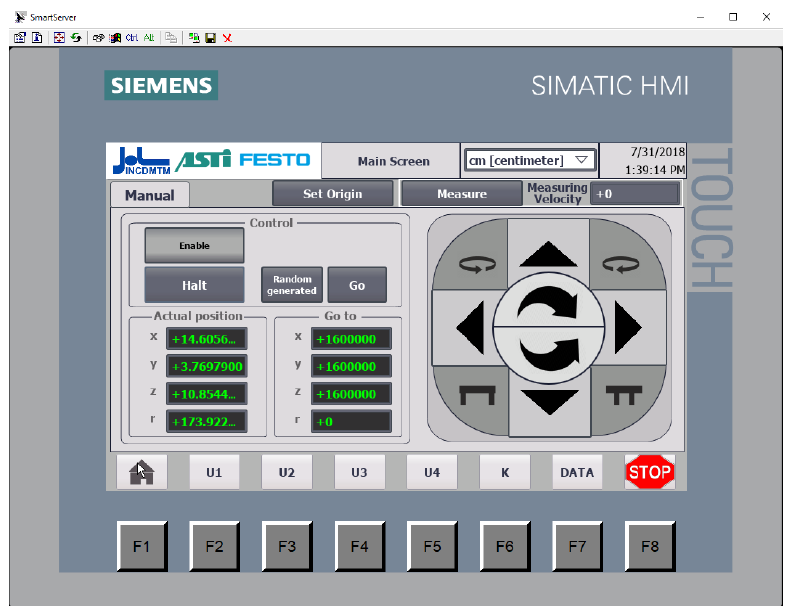
Figure 18. Center panel view.